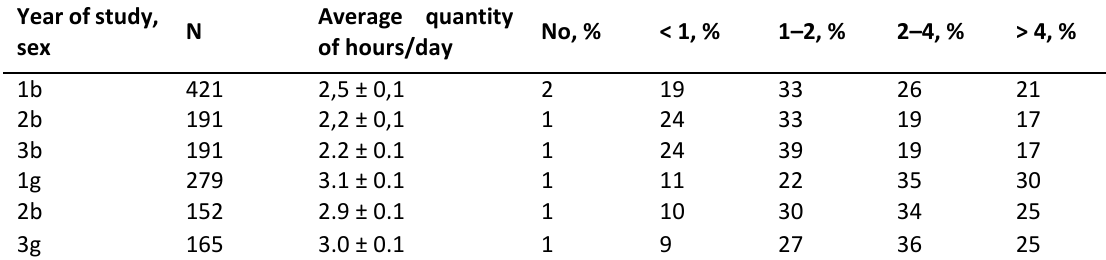
Table 1. Distribution of students by time (hours/day), spent for Internet